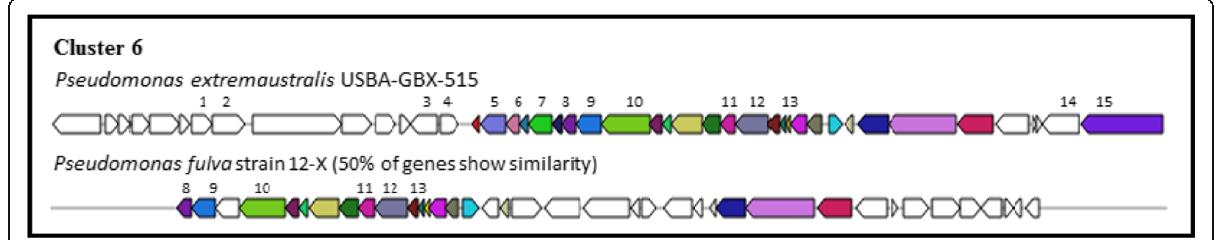
Fig. 9 Genetic map of arylpolyene saccharide biosynthetic gene cluster 6 detected by AntiSMASH 3.0. The genes were designated by colors. Same color means equal genes in different strains, not-colored means other genes. 1. 3-dehydroquinate synthase; 2. hypothetical protein PA5037; 3. major facilitator superfamily transporter; 4. Transcriptional regulator; 5. 3-oxoacyl-(acyl-carrier-protein) synthase II FabF; 6. beta-ketoacyl synthase; 7. SAM-dependent methyl- transferase type 11; 8. FAD-binding protein; 9. MMPL family efflux pump permease component. 10. glycosyl transferase; 11. AMP dependent synthase; 12. acyl carrier protein; 13. Acyltransferase; 14. acyl-CoA dehydrogenase; 15. fused DNA-binding transcriptional